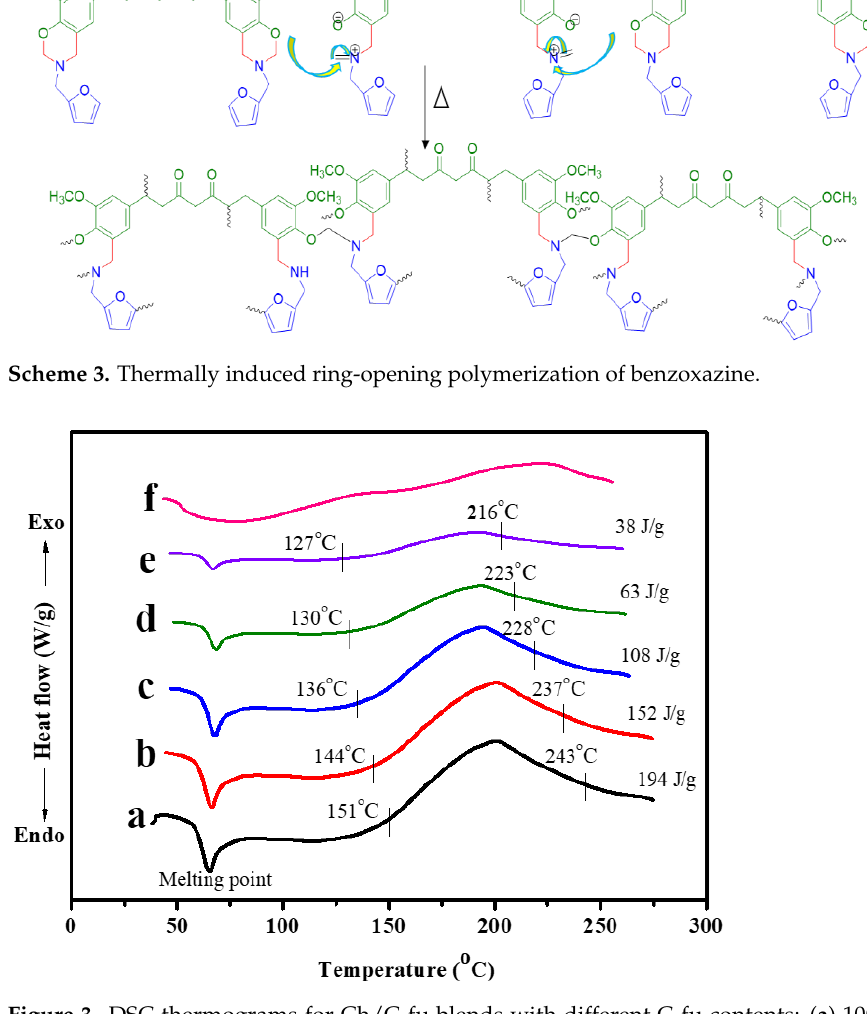
Figure 3. DSC thermograms for Ch/C-fu blends with different C-fu contents: ( a ) 100%, ( b ) 80%, ( c ) 60%, ( d ) 40%, ( e ) 20%, and ( f ) 0%. Table 1. DSC data of poly(Ch/C-fu) blends.